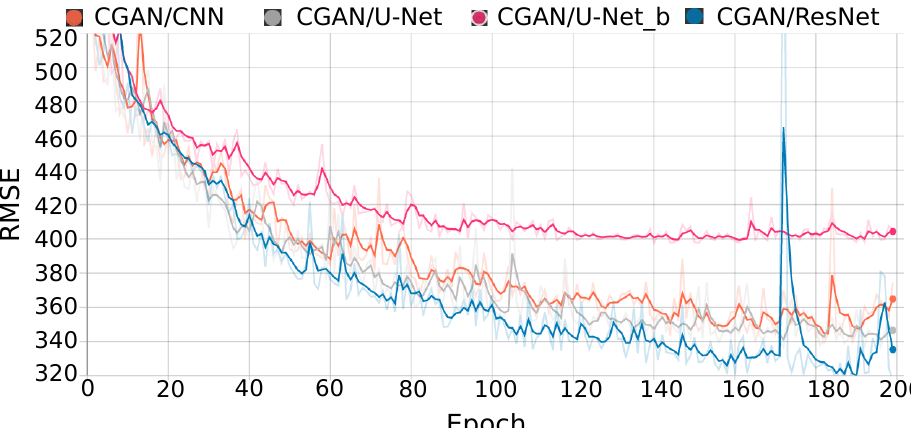
Figure 10. Root Mean Square Error (RMSE) during training of the CGAN with different networks as generators, CNN, U-Net, U-Net_b [20,36] and ResNet, using the validation